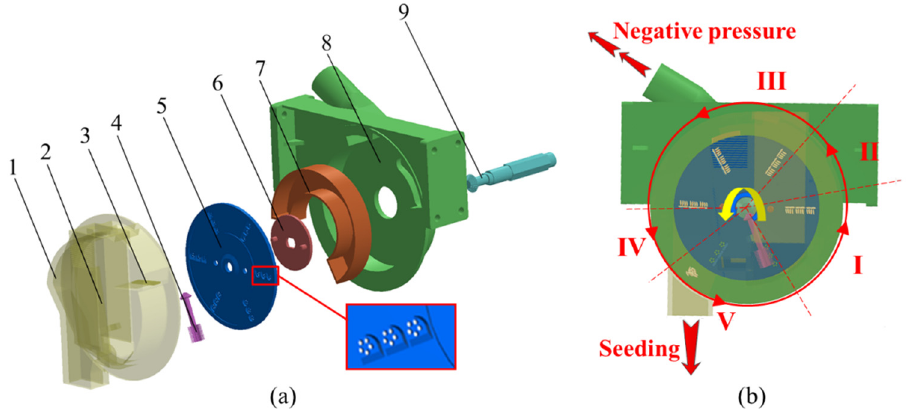
Figure 1. Multi-grain cluster air suction type rice hill direct seed metering device: ( a ) overall Scheme; ( b ) working principle. 1. front shell; 2. unloading brush; 3. cleaning brush; 4. stirring brush; 5. seed metering plate; 6. transmission plate; 7. negative pressure chamber; 8. back shell; 9. transmission shaft. I. filling area; II. clearing area; III. carrying area; IV. unloading area; V. transitioning area. Table 1. The structural parameters of key components. Parameter Value Unit Diameter of seed metering plate